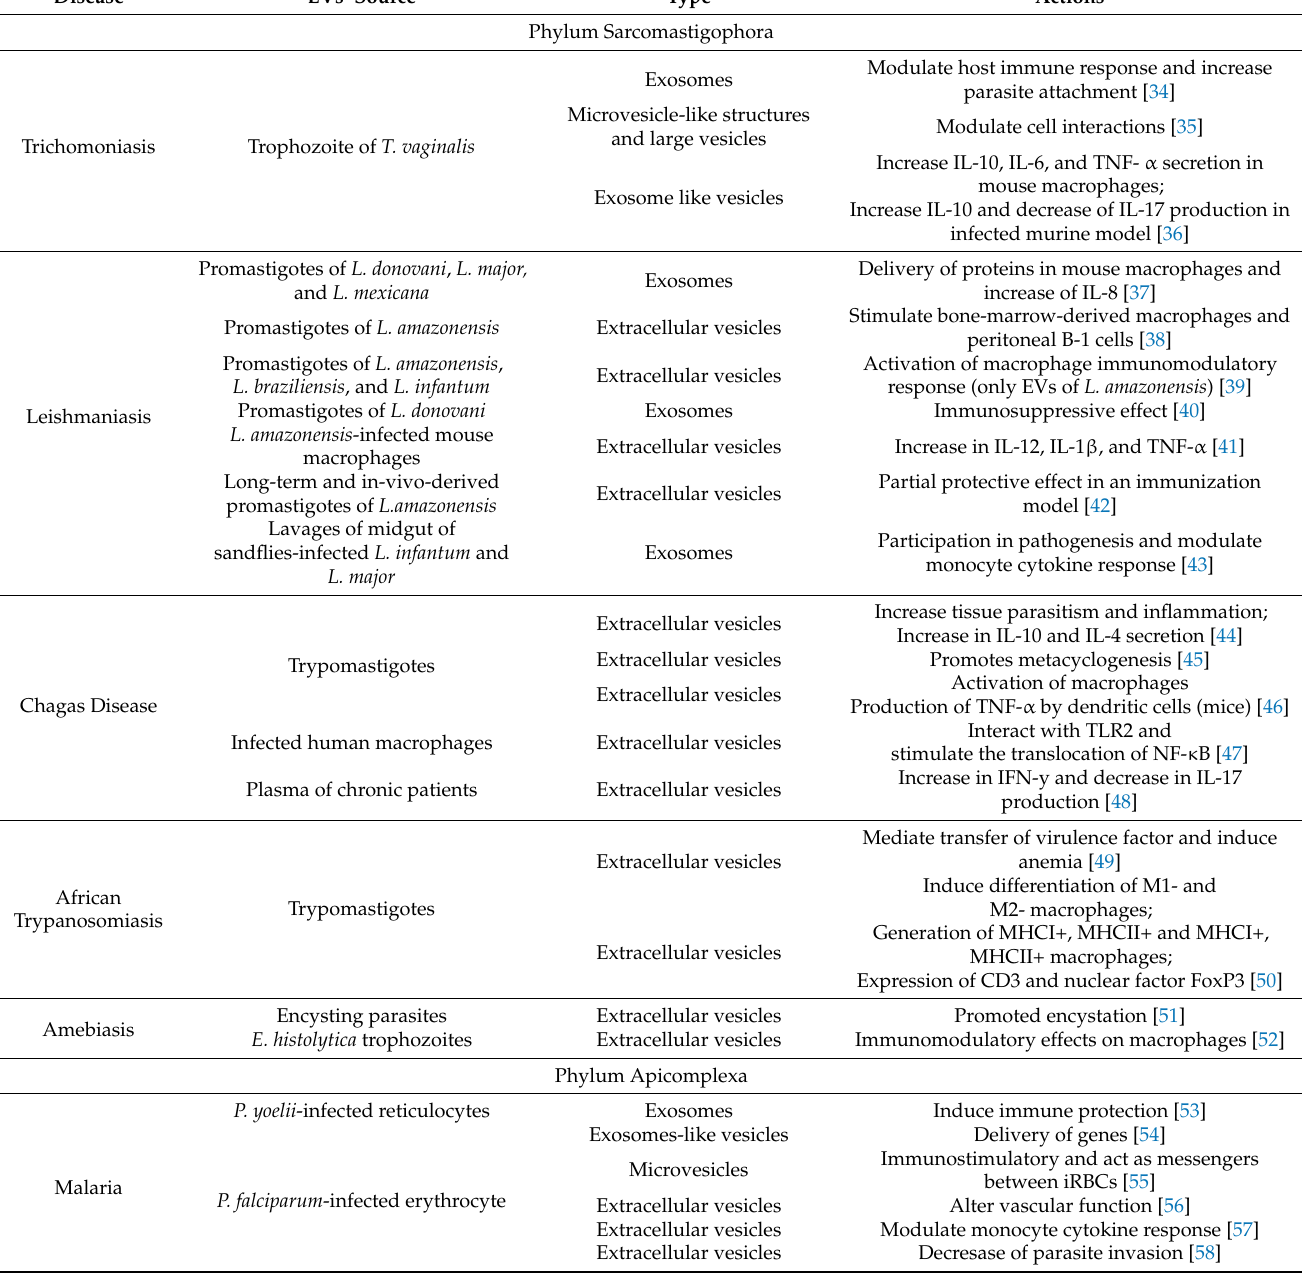
Table 1. Role of protozoa extracellular vesicles in host